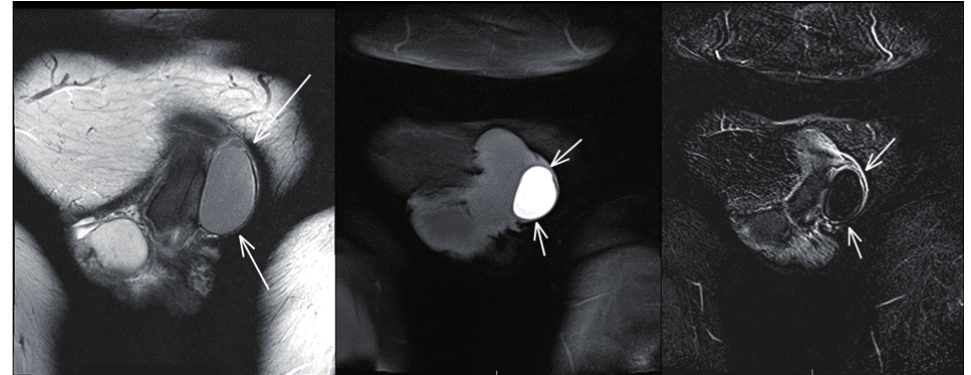
Figure 1. a : T-2 MRI reveals non-enhancing 4.1 cm lesion abutting the left corpus cavernosa and exerting mild compression on the left corpus cavernosum. b : T-1 MRI without contrast shows a homogenous rim enhancing lesion without solid components. c : Subtraction MRI of lesion. Differential for this lesion based on imaging is proteinaceous fluid versus subacute